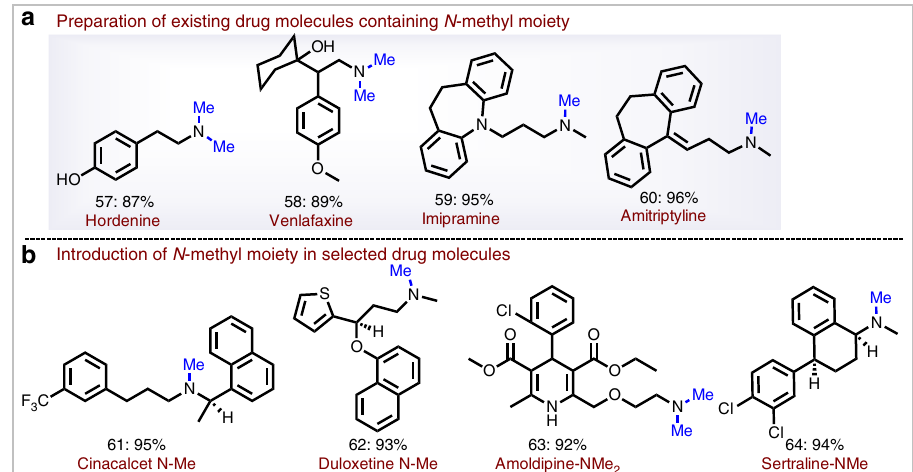
Fig. 6 Synthesis of pharmaceutical N, N -(di)methylamines from the corresponding amines i . a i Reductive amination protocol demonstrating for the preparation of existing drug molecules. b Selective introduction of N -methyl moiety in drug molecules i Reaction conditions: 0.5 mmol amine, 50 mg Fe 2 O 3 /